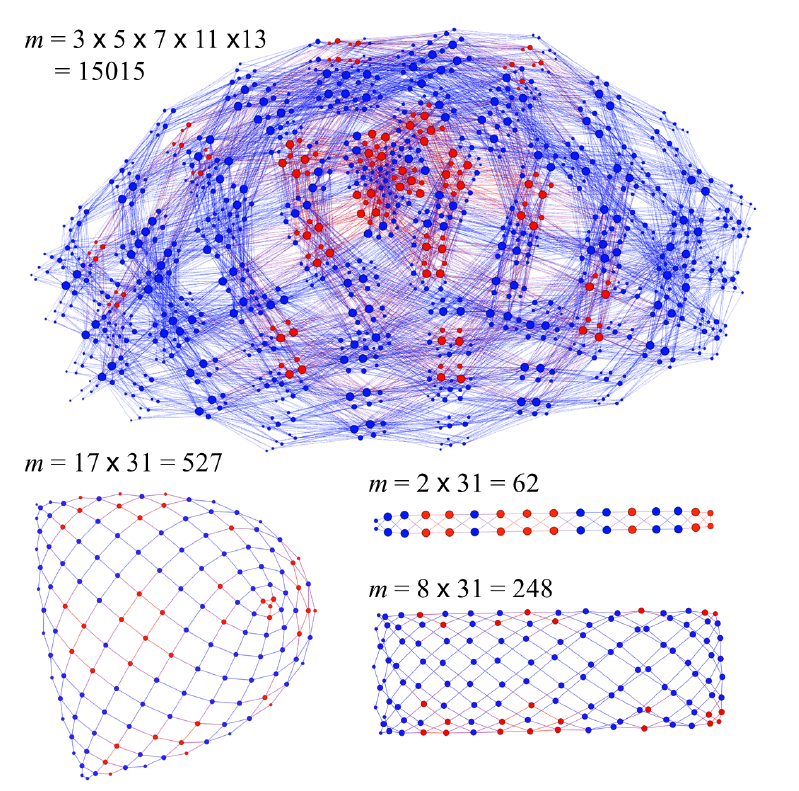
Figure 12. Examples of graphs in which m is composite. The top graph shows the case for m = 3 × 5 × 7 × 11 × 13 = 15,015. High composites get rather complicated, but one can still see a web-like overall structure which is the nature of double composites (two distinct primes). The lower graphs show three examples. In cases where both primes are odd, there is one vertex of degree one; otherwise, the nodes are of degree four (interior of the web) or two (edge of the web). Additionally, on graphs for all products of two odd primes there are p 1 is always exactly one triangle. The remaining internal faces are four-sided quadrilaterals. The graphs are colored according to whether a vertex represents a perfect square (red) or a nonsquare (blue).